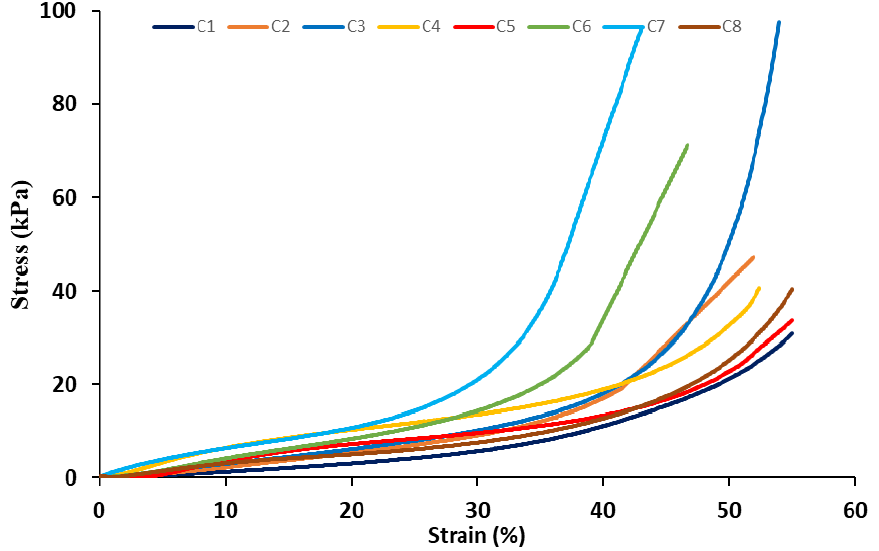
Figure 6. Compressive stress-strain curves of the unmodified and modified CNC aerogels.